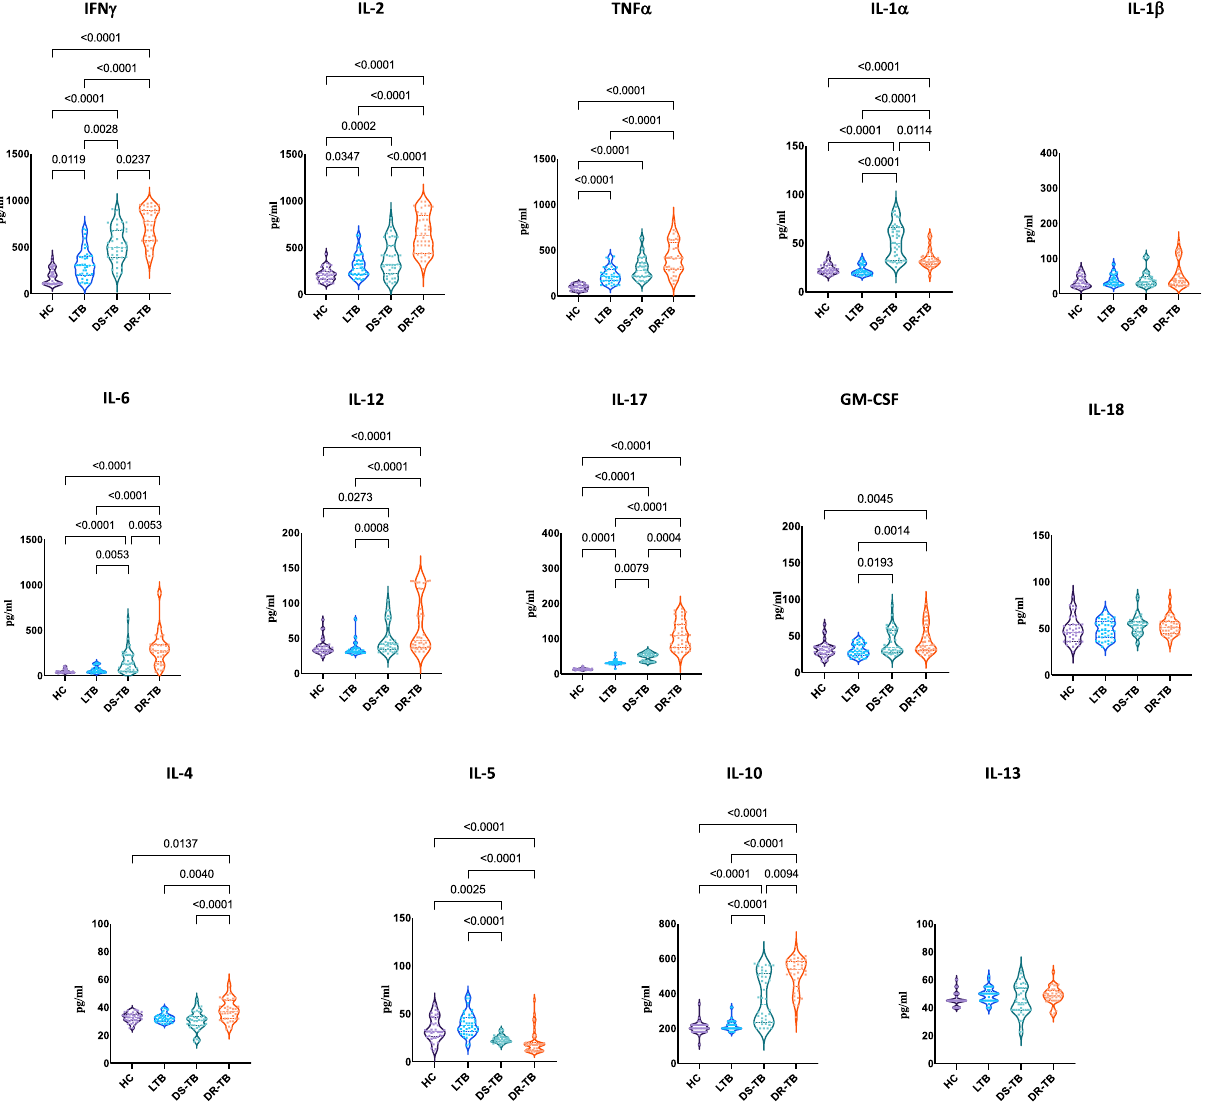
Figure 1. Altered cytokine profile among DS-TB and DR-TB groups compared to HC or LTB groups. Statistical differences were analysed by Dunn test corrected for multiple comparisons using Bonferroni test and significant p values < 0.05 were mentioned in the